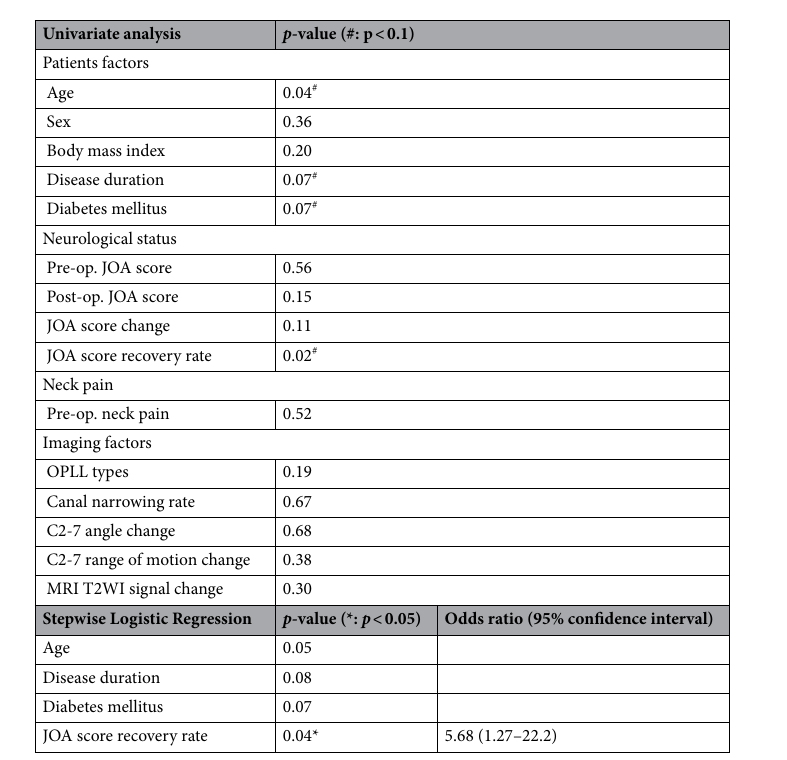
Table 4. Statistical analyses. Age, diabetes mellitus, disease duration and JOA score recovery rate were identified as possible candidates for factors having significant association with postoperative neck pain attenuation by initial uni-variate analyses. Stepwise logistic regression analysis revealed the JOA score recovery rate as an independent factor having a significant positive association with post-operative neck pain attenuation ( p = 0.04, odds ratio 5.68 (95% confidence interval: 1.27–22.2), Table